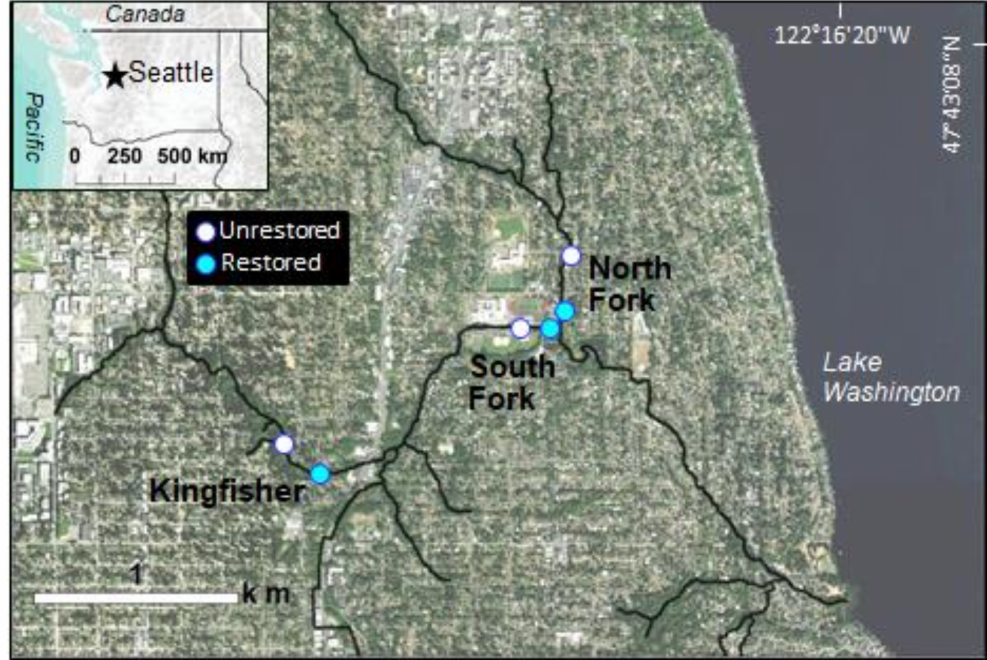
Figure 1. Locations of restored and unrestored study reaches within the Kingfisher and Confluence (North Fork and South Fork) floodplain restoration projects on Thornton Creek, in the NE quadrant of the City of Seattle. Inset map shows location of Seattle within Washington State,